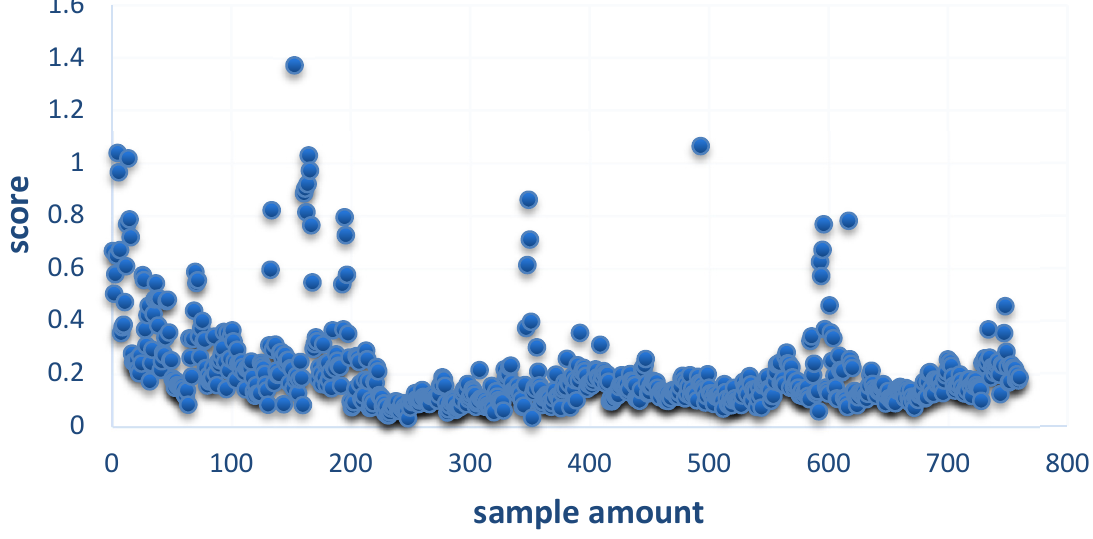
Figure 4. Efficiency score distribution of all samples.